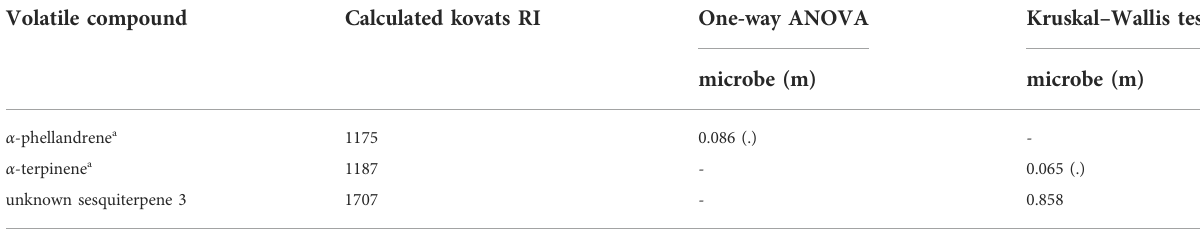
TABLE 2 Volatiles emitted by tomato plants according to their measured retention time and calculated Kovats retention index (RI).